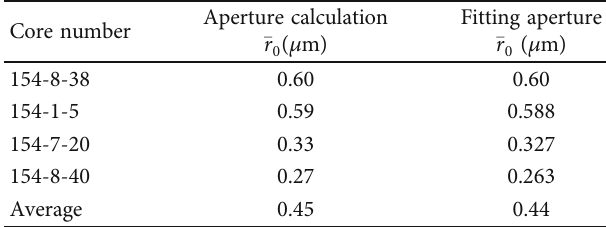
Table 4: Calculation and fi tting results of experimental core pore diameter.